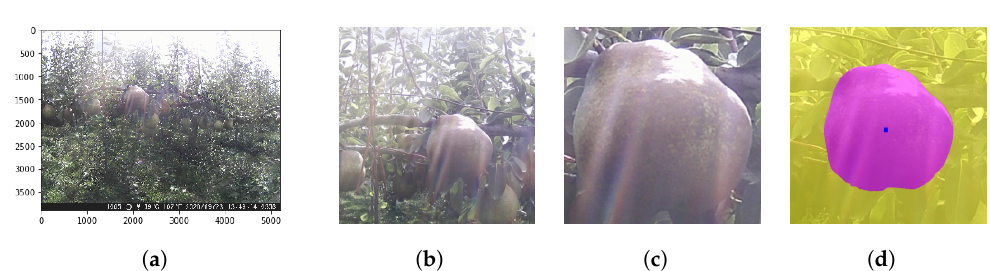
Figure 11. ( a ) The original image of 5200 × 3900 pixels. ( b ) Choosing the target fruit roughly manually. ( c ) CROP will then recognize the central fruit. ( d ) It will measure the area as the number of pixels of the mask and give the 2D-wise center of mass. The pixel number is re-scaled in the scale of ( a ) and hence is in general decimal. See Figure 12 for how to obtain the mask. The image ID is 338.